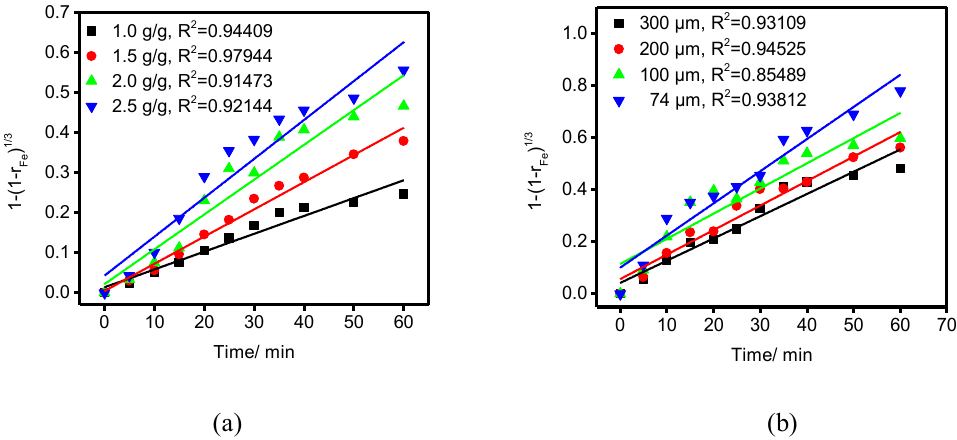
) − 3(1 − r ) 2/3 and (b) 1 − (1 − r ) 1/3 vs time. Fe Fe Fe